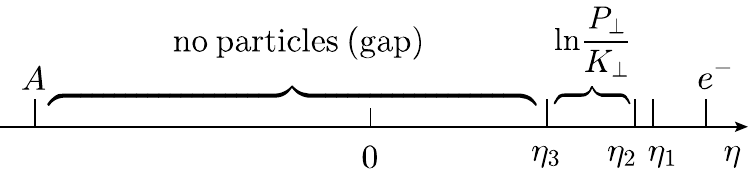
Figure 15 . The pseudo-rapidity distribution expected for the final state of diffractive 2+1 jet production in DIS. A similar distribution should be observed for the corresponding events in UPCs, except for replacing the final electron ( e − ) by the nucleus which emits the